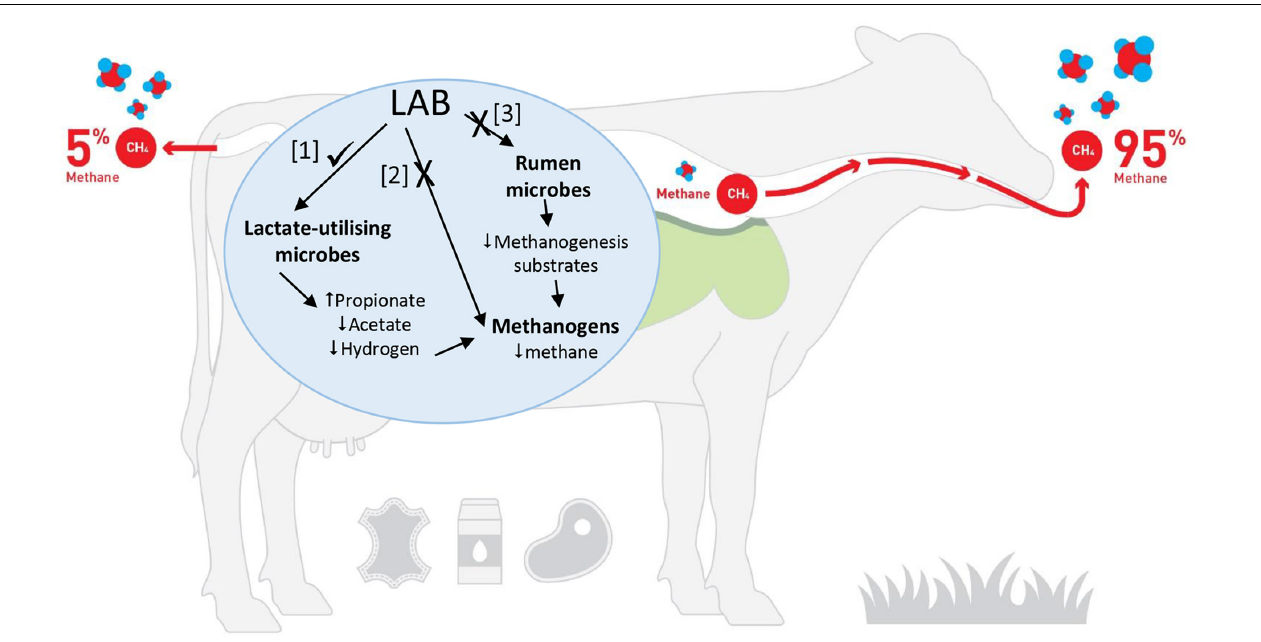
FIGURE 1 | Potential pathways that could be modulated by LAB to decrease CH 4 production [Adapted from FAO (2019). Image is being used with the permission of the copyright holder, New Zealand Agricultural Greenhouse Gas Research Centre